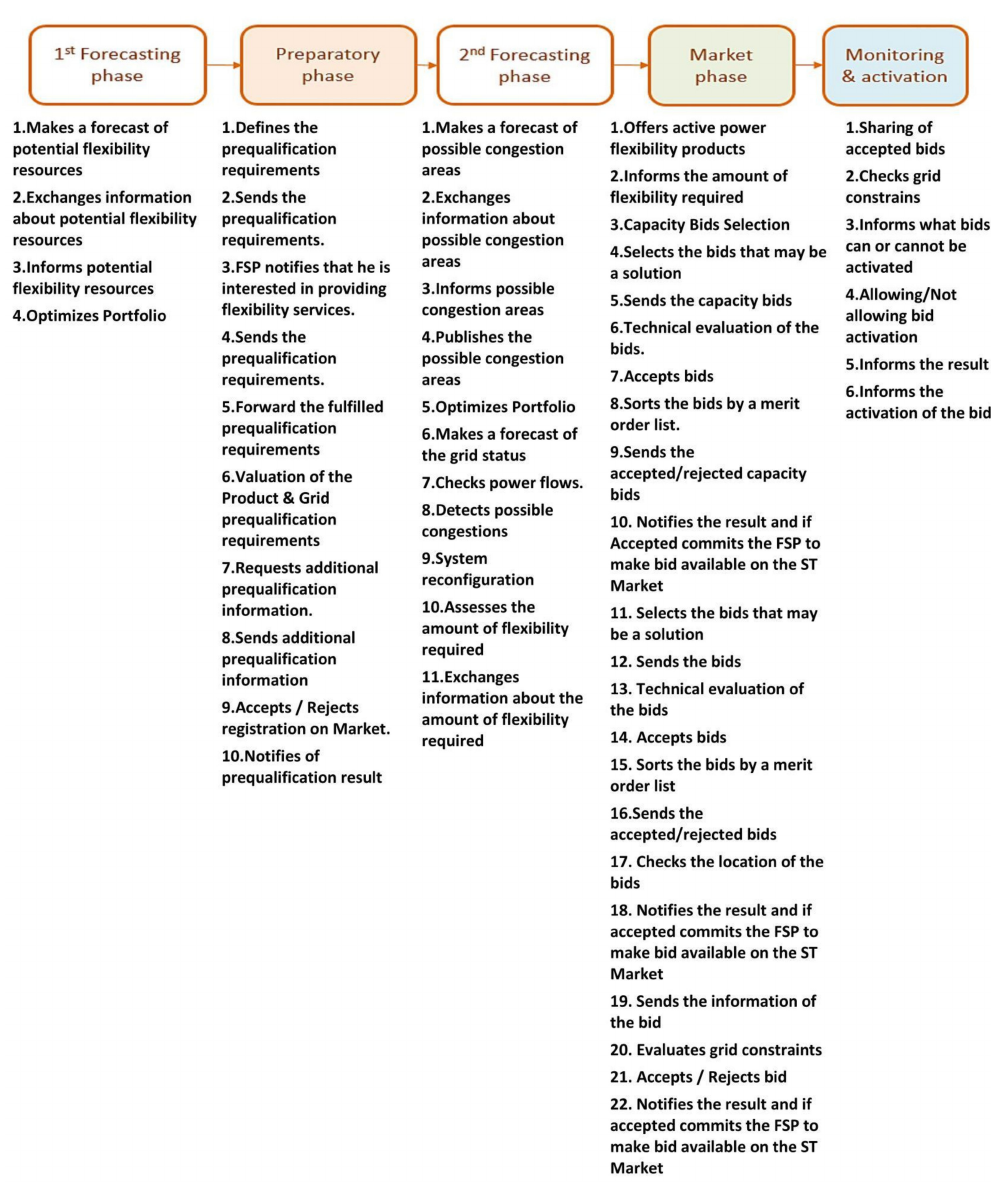
Figure 10. Diagram of the market process in the BUC. Table 4. Information on the scenarios for